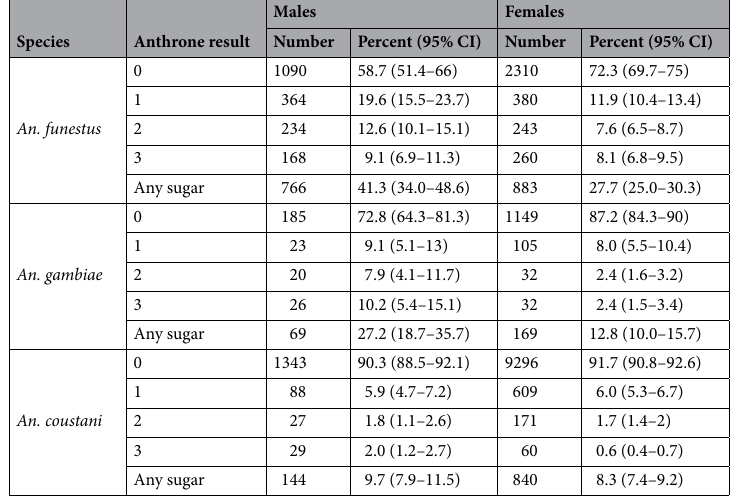
Table 2. The intensity of sugar feeding by species. Zero is interpreted as unfed mosquitoes while increasing intensities of sugar feeding are indicated as 1, 2 and 3.